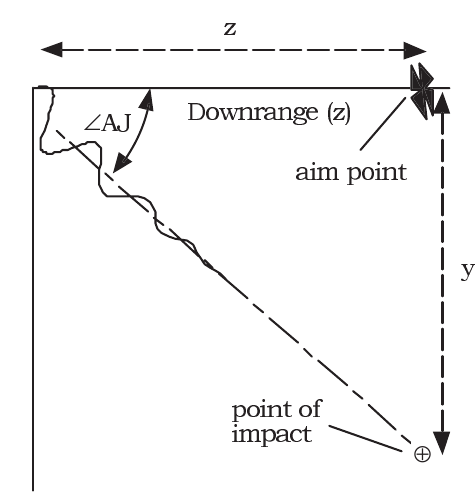
Fig. 3. Hypothetical CG trajectory extended to the target.